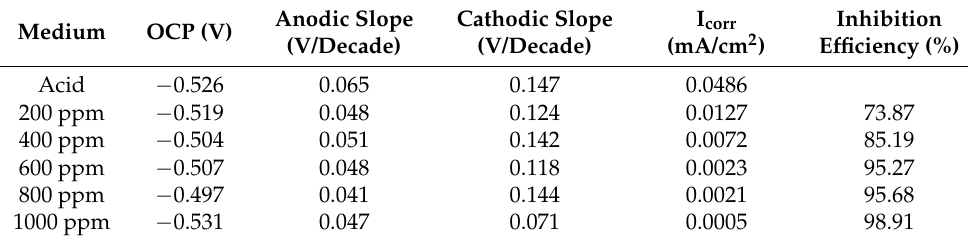
Table 4. Anodic and cathodic slopes and inhibition efficiencies for the as-immersed samples.